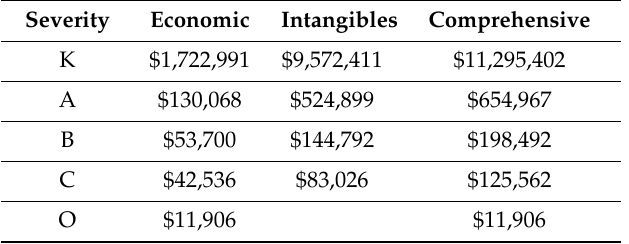
Table 2. National KABCO (Fatal Injury (K); Suspected Serious Injury (A); Suspected Minor Injury